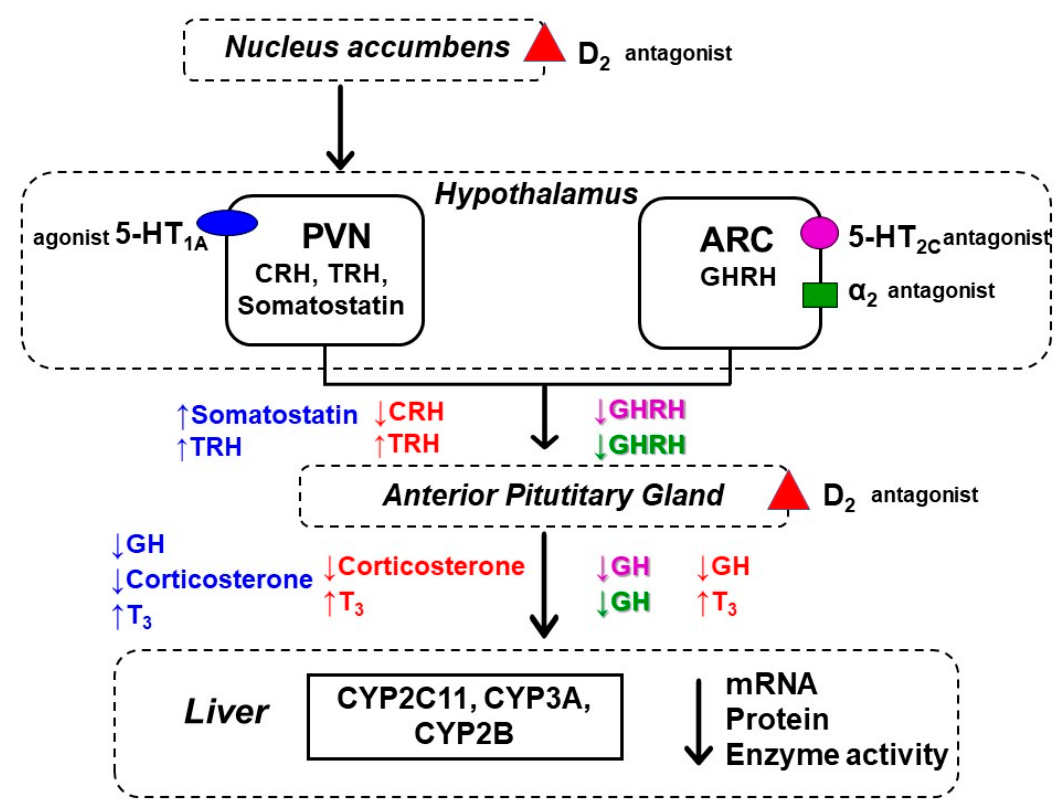
Figure 5. The central neuroendocrine regulation of liver cytochrome P450 by asenapine (a hypothetical scheme). The D 2 receptor blockade in the pituitary decreases GH release and increases TSH-thyroid hormone (T 3 ) secretion, which leads to down-regulation of the hormone-dependent CYP2C11, CYP3A1 and CYP2B1 expression/activity in the liver. The nucleus accumbens of the mesolimbic system projects to the paraventricular nucleus (PVN) of the hypothalamus. The D 2 receptor blockade in the nucleus accumbens decreases the CRH release and corticosterone secretion and increases TRH release and thyroid hormone (T 3 ) secretion, which leads to down-regulation of the above-mentioned enzymes (based on Wójcikowski and Daniel [13,17]). The activation of the 5-HT 1A receptors in the PVN increases somatostatin and TRH release, which leads to decreased GH and corticosterone secretion and increased T 3 secretion and, in turn, to a reduction in the hormone-dependent CYP2C11, CYP3A1 and CYP2B1 expression/activity in the liver (based on Bromek and Daniel [16]). The 5-HT 2C receptor blockade in the arcuate nucleus (ARC) of the hypothalamus inhibits GHRH release and thus pituitary GH secretion, which leads to decreased expression/activity of the GH-dependent CYP2C11 and CYP3A1 (based on Bromek and Daniel [16]). The α 2 receptor blockade in the ARC inhibits the GHRH-GH hormonal pathway and down-regulates the GH-dependent expression/activity of CYP enzymes in the liver (based on Sadakierska-Chudy et al. [14] and Bromek et al. [16]). ARC, arcuate nucleus; GHRH, growth hormone-releasing hormone; GH, growth hormone; PVN, the paraventricular nucleus; CRH, corticotropin-releasing hormone; TRH, thyrotropin-releasing